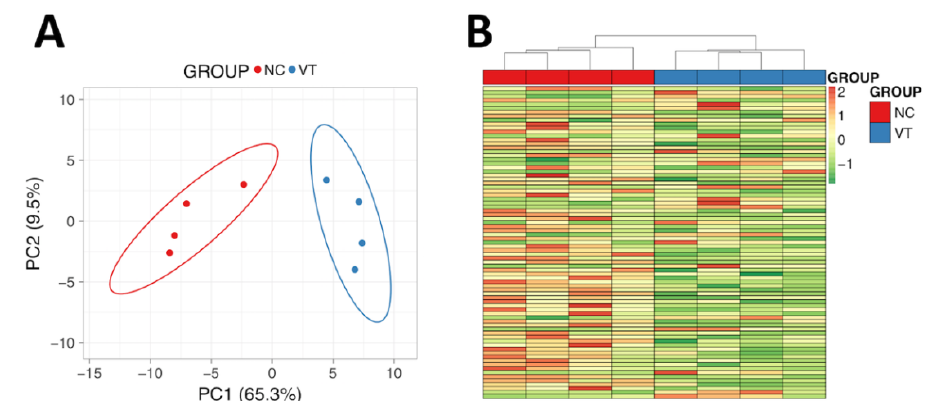
Figure 3. Molecular analysis of male liver samples obtained from adult males derived from vitrified-transferred embryos (VT) and naturally conceived animals (NC). ( A ) Principal Component Analysis. ( B ) Heat-Map clustering. The representation of sample variability between the experimental groups was performed, taking into account only the differentially expressed proteins. PC1: Principal Component 1. PC2: Principal Component 2.